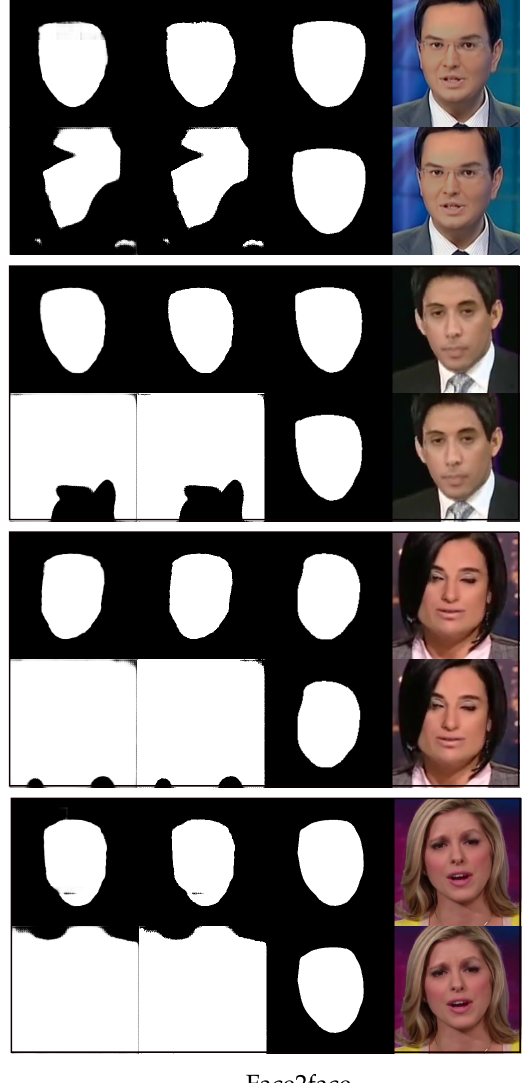
Figure 5. Four rows of randomly selected images from Face2Face and their predicted results for the fake region with one-shot fine-tuning. The top sub-row of each row is the result generated by the proposed method, and the bottom sub-row of each row is the result without using the proposed method. In each sub-row, from right to left, there is the image altered by Face2Face , the ground truth of the altered region (mask), the binary predicted output, and the gray-scale predicted